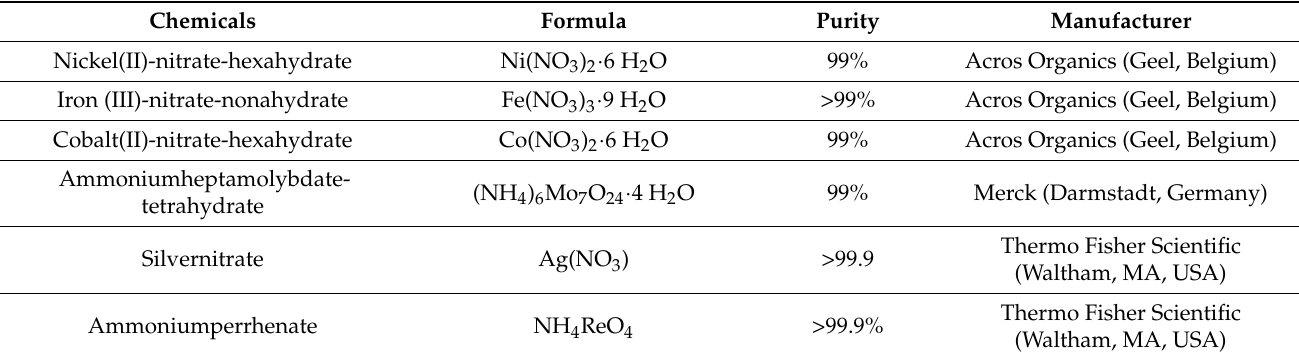
Table A3. Overview of the chemicals used for syntheses with their purity and